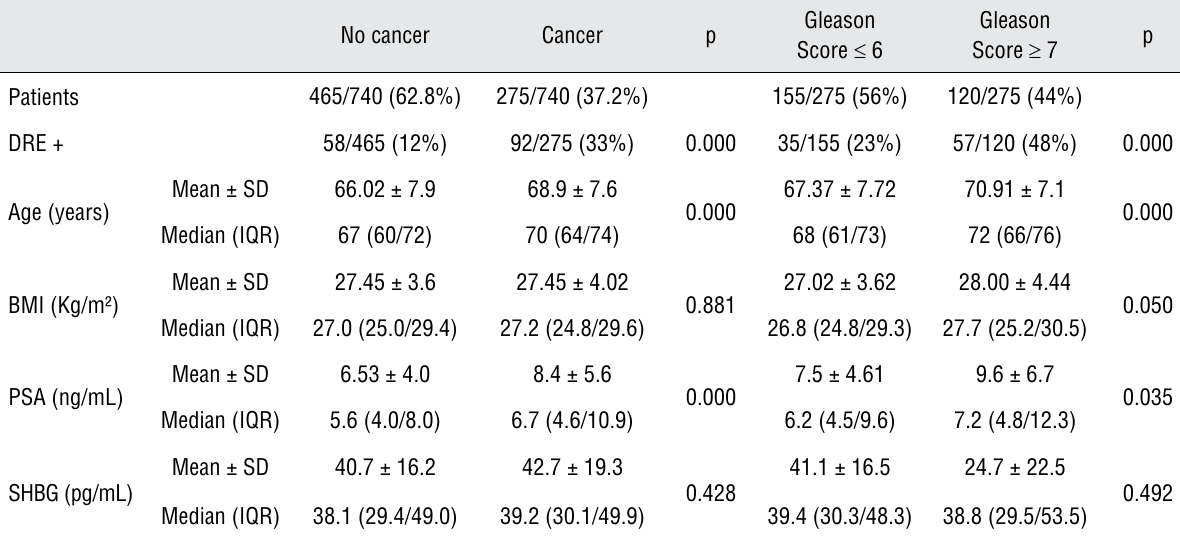
Table 2 - Clinical and pathological characteristics of the